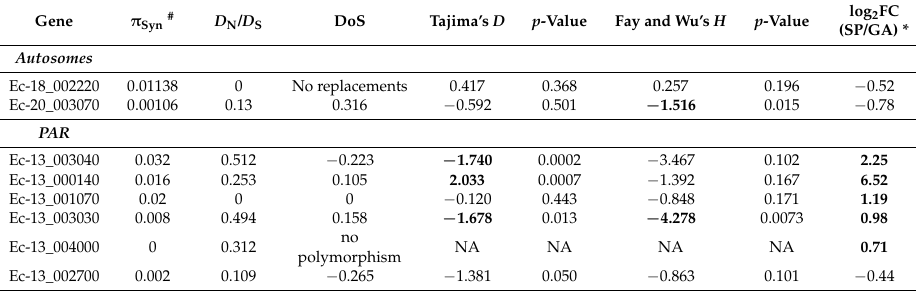
Figure 4. Neutral diversity of PAR and SDR genes in Ectocarpus siliculosus . ( A ) Physical position of the studied PAR genes on the sex chromosome. Gene names are indicated, the sex-determining region (SDR) is marked in red (female) and blue (male); ( B ) Diversity of the studied autosomal, PAR and SDR genes at synonymous sites. The level of differential expression (fold change) of the PAR genes in the sporophyte (SP) and gametophyte (GA) generations is represented by the colored circles (green denotes strong GA-bias and red stands for strong SP-bias). Table 2. Measurements used to infer the evolutionary forces acting on autosomal, PAR and SDR genes. Significant p -values ( p < 0.05) for the neutrality tests and for the bias in expression between generations are shown in boldface.